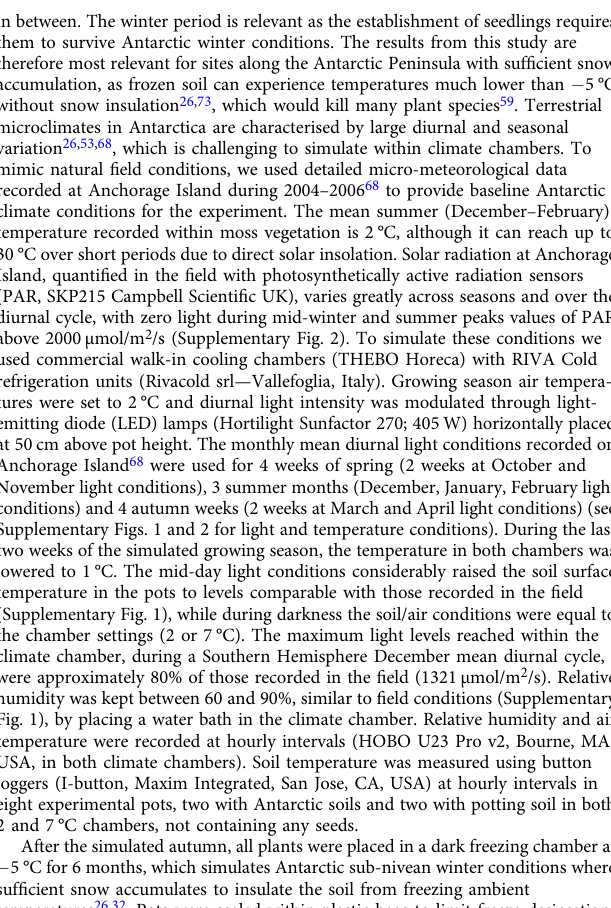
Bleiswijk, The Netherlands; Potting soil No. 4). Finally, to test for any temperature limitations on seed germination and growth, we placed fi ve replicate pots/species with potting soil and the same seeding density as used for the main experiment at 15°C. Eucalyptus coccifera and E. perriniana germinated at 15 °C but failed to germinate at both 2 and 7°C in either soil type (Supplementary Tables 6 – 8). Plants that germinated at 2 and 7 °C did so in both potting soil and Antarctic soil. Antarctic climate simulation . The experiment ran for two simulated Antarctic growing seasons with 6 months of simulated winter conditions ( − 5°C in darkness)